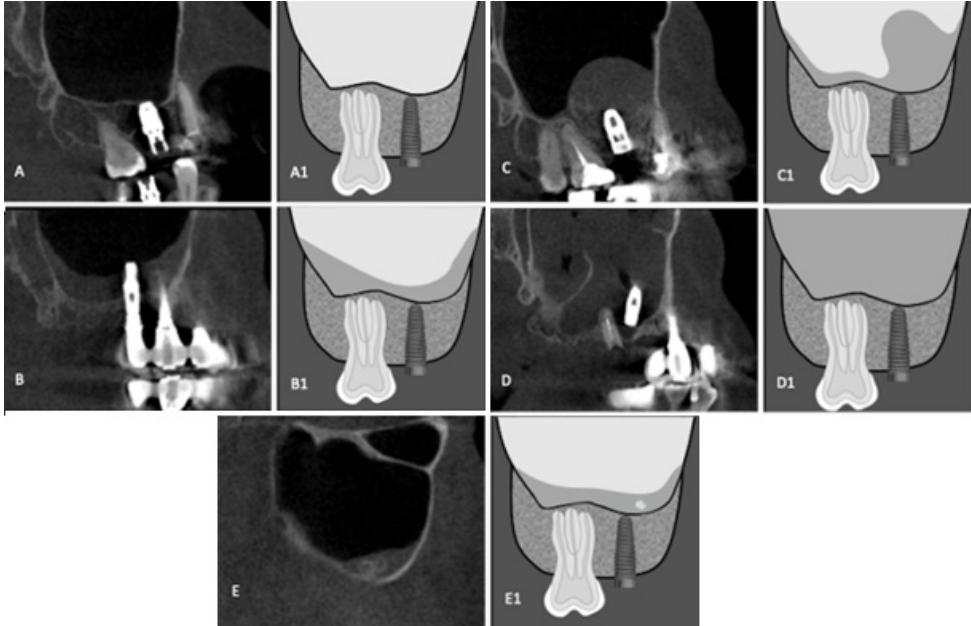
Figure 3. CBCT reconstructions and schematic drawing of maxillary sinus abnormalities. ( A , A1 ) Normal Maxillary Sinus; ( B , B1 ) Mucosal thickening; ( C , C1 ) Antral pseudo cyst; ( D , D1 ) Non-specific opacification; ( E , E1 ) Antrolith.